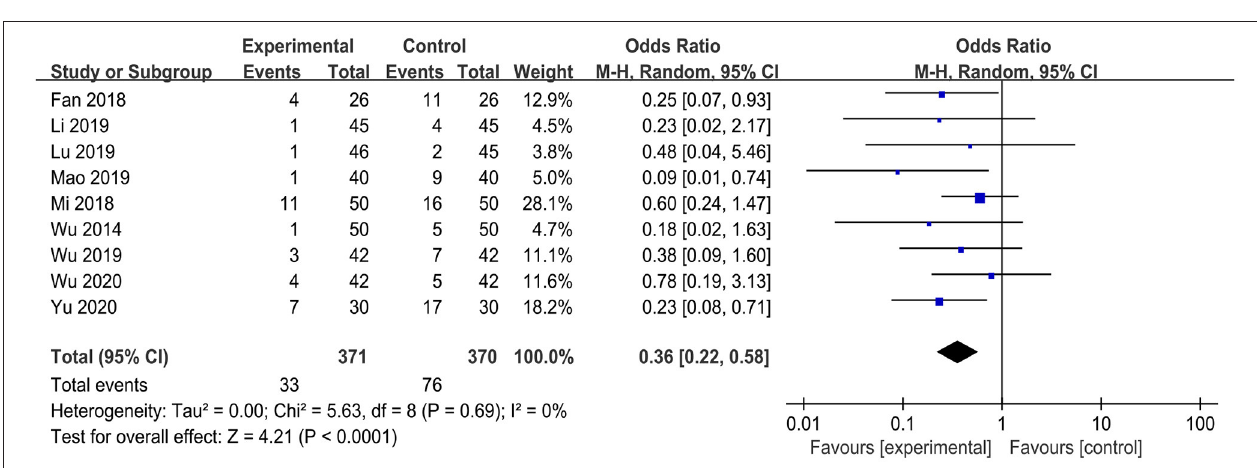
FIGURE 6 | Meta-analysis and forest plot for the incidence of